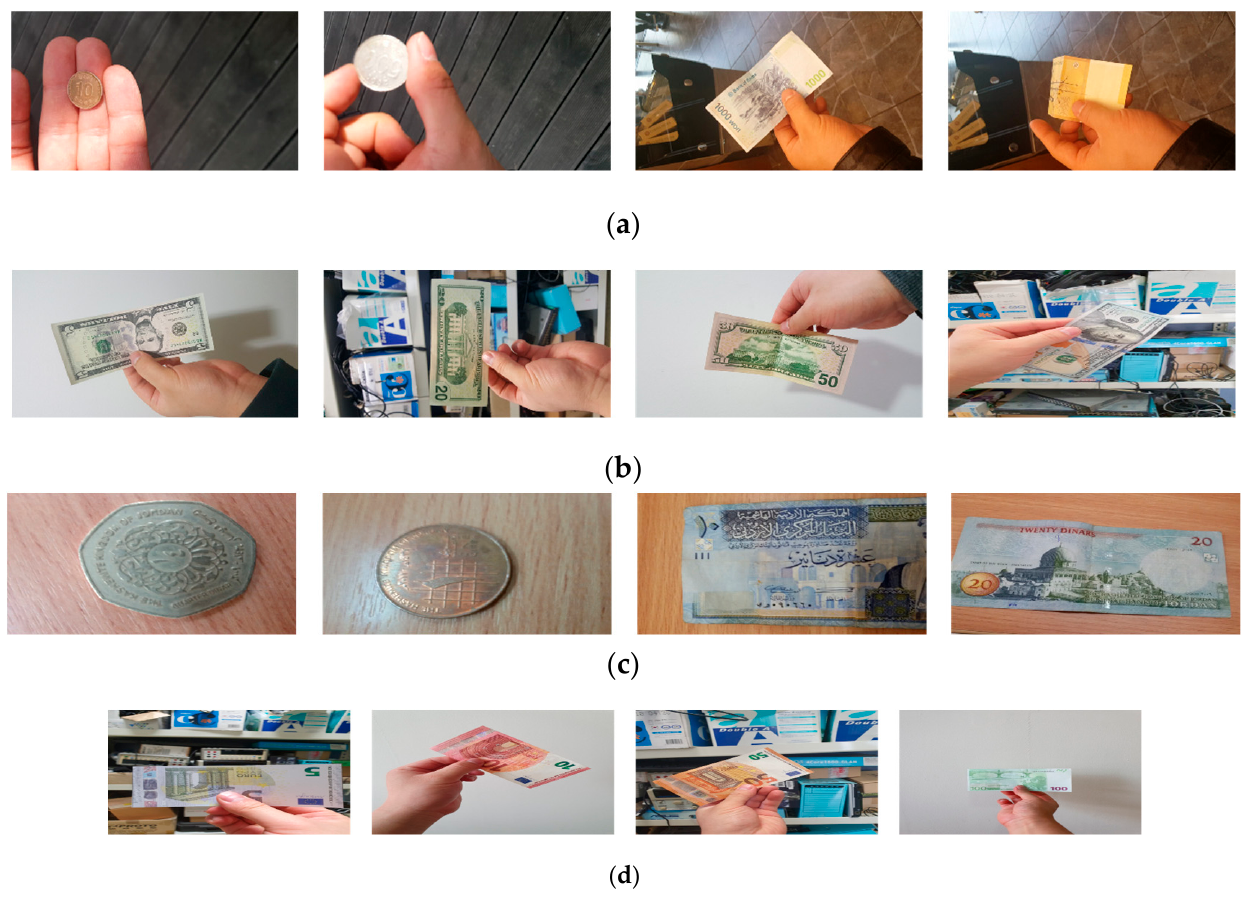
Figure 5. Examples of database images: ( a ) is KRW, ( b ) is USD, ( c ) is JOD, and ( d ) is EUR.